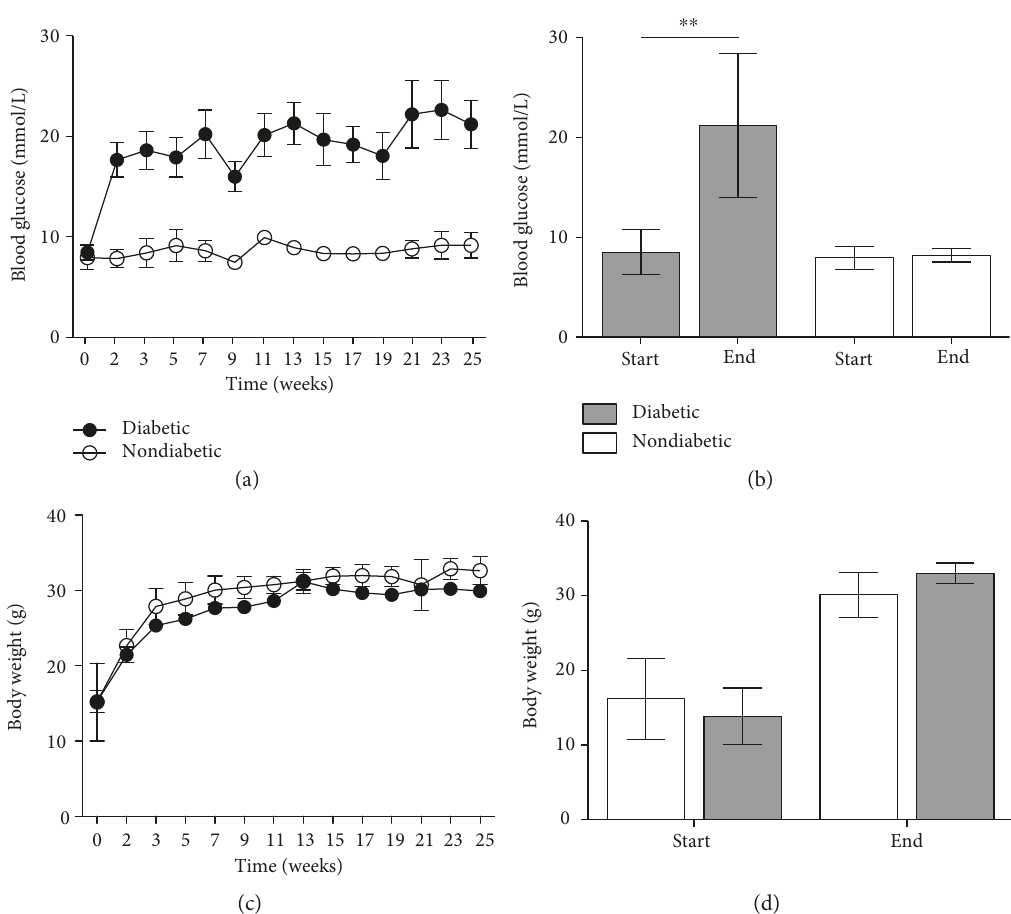
Figure 1: Measurement of blood glucose and weight in diabetic and control mice. (a) Blood glucose measurement of diabetic and nondiabetic mice, (b) change in blood glucose from start to end of the study for diabetic (start: n = 16 , end: n = 12 ) and nondiabetic (start: n = 13 , end: n = 12 ) mice. (c) di ff erence in body weight during the study, (d) di ff erence in body weight from start to end of the study for diabetic (start: n = 16 , end: n = 12 ) and nondiabetic (start: n = 13 , end: n = 12 ) mice. Student ’ s t -test was used to test the di ff erence between groups, which was indicated in the fi gure when signi fi cant. ∗∗ p < 0 01 . Data is given in mean with standard deviations 1 : 1000 in C3a washing bu ff er added with 25 μ M EDTA and incubated for 1 h at RT. The wells were washed fi ve times in cold C3a washing bu ff er and read as described above.